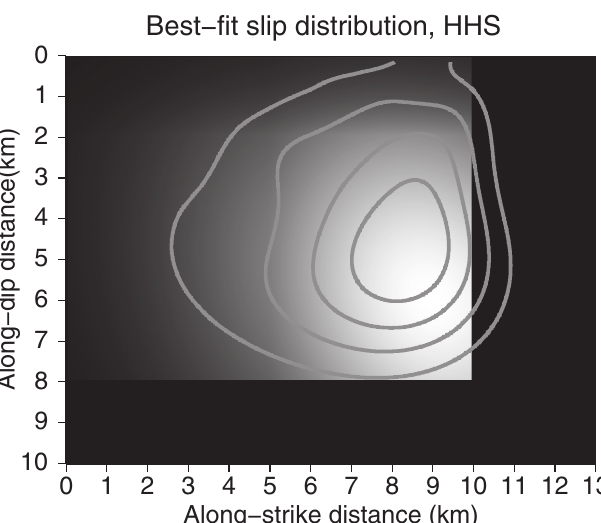
Fig. 10. Best fit 40 × 32-subfault slip distribution ( f = 3 × 10 10 gray contours) over the distributed-slip source fault.